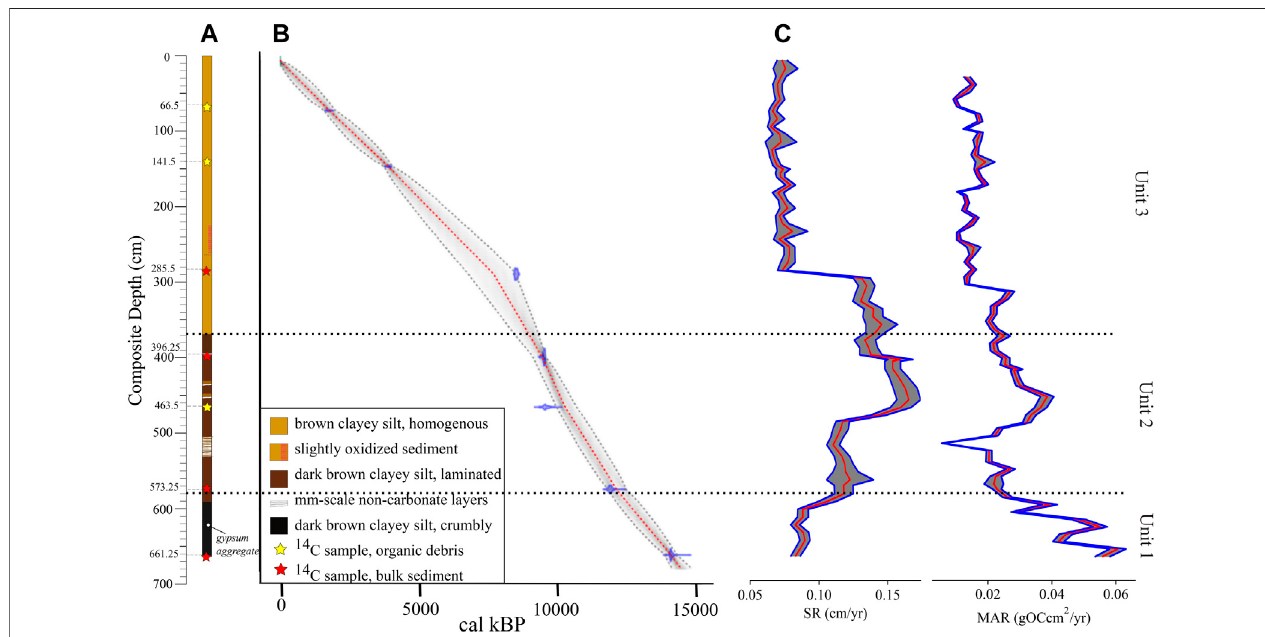
FIGURE 2 | (A) General stratigraphy and (B) age-depth model of the sediment core, based on radiocarbon dating of 7 samples, shown as green/yellow stars (see details in Table 1 ). (C) Inferred sedimentation and mass accumulation rate (SR and MAR) curves along the core, based on the age-depth model.